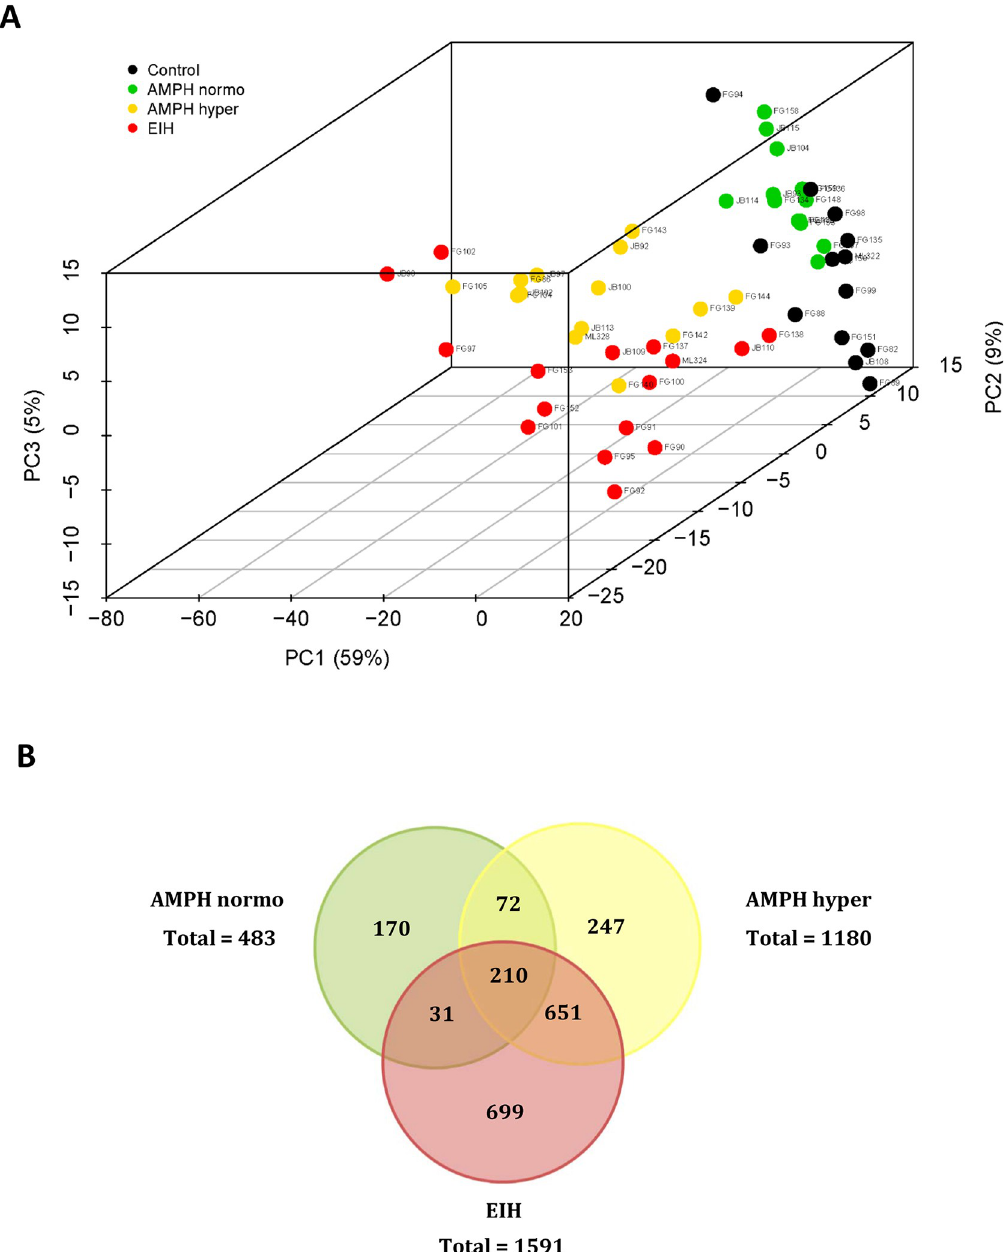
Fig 1. PCA and venn diagram analysis. A. Principal component analysis score plot (3 principal components) of AMPH normo, AMPH hyper, EIH, and control treatment groups. B. Venn diagram showing the overlap of significant transcripts between the three main pairwise comparisons based on RNA-seq data